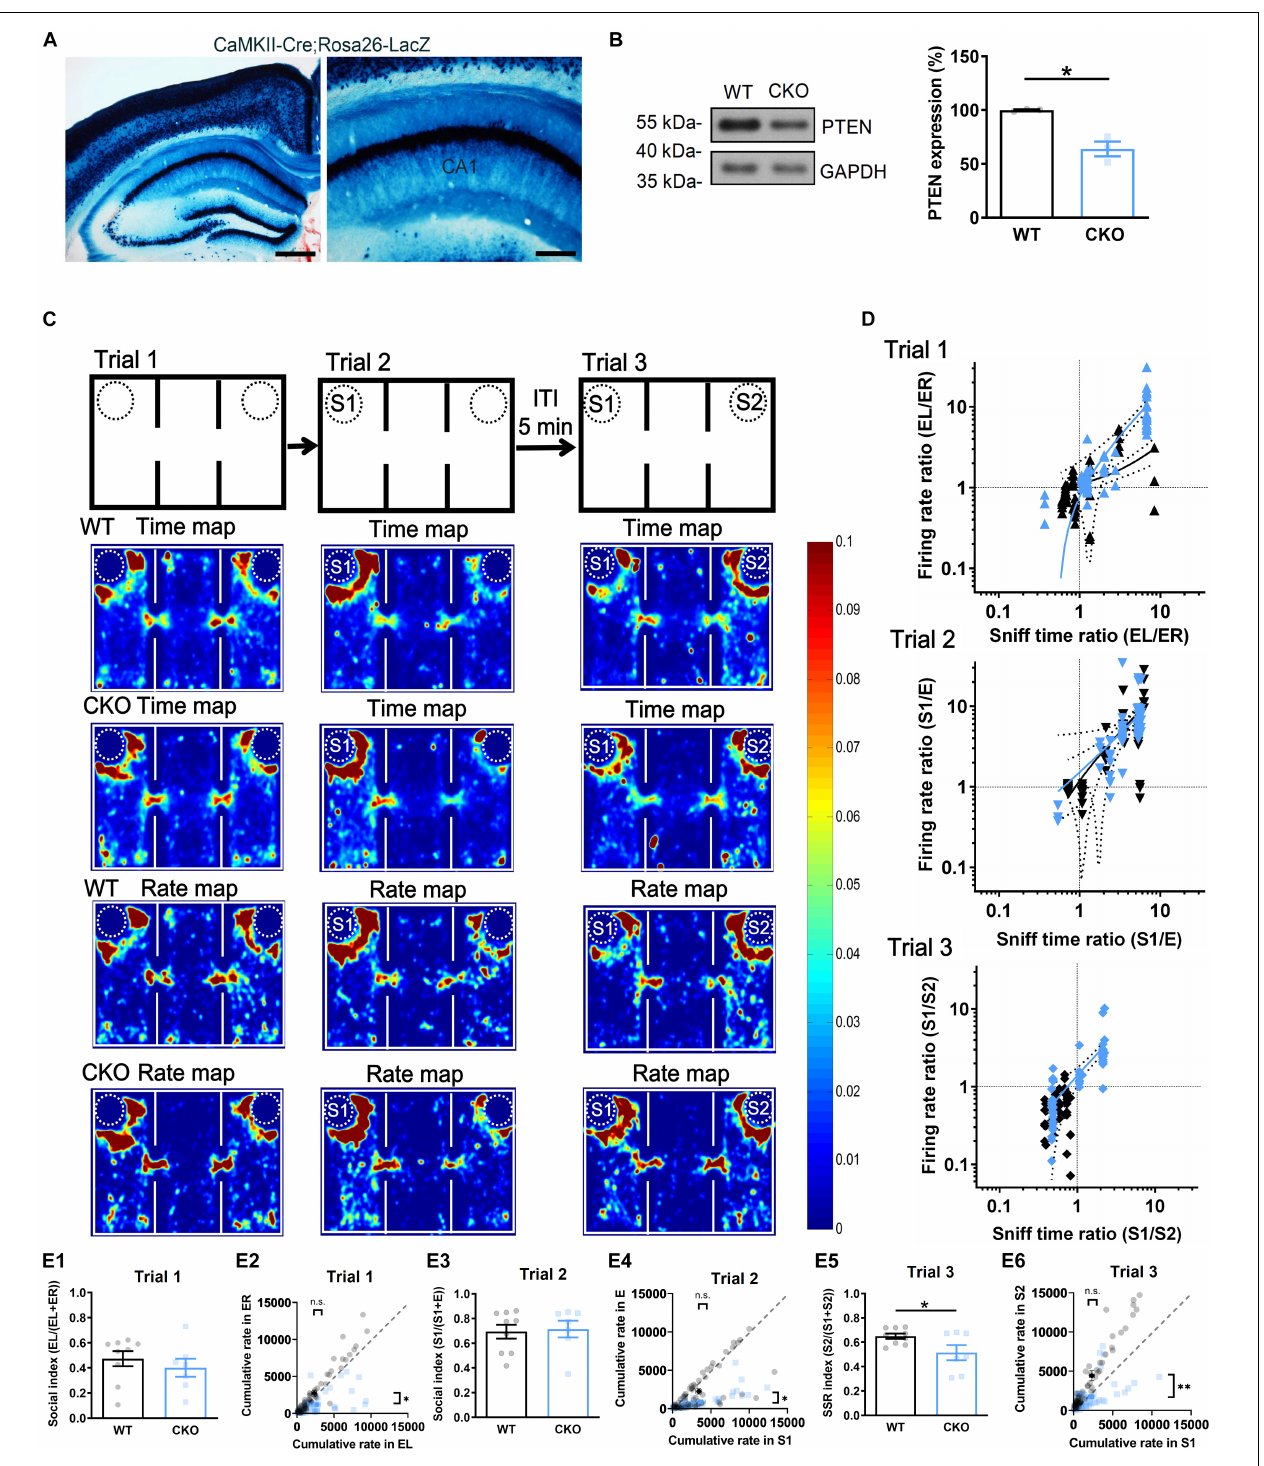
FIGURE 5 | Altered CA1 neuronal firing pattern during social recognition in conditional forebrain PTEN knockout (CKO) mice. (A) X-Gal staining of Cre activity in CaMKII-Cre;Rosa26-LacZ mouse. Calibration bars: Left, 500 µ m; Right, 200 µ m. (B) Western blot of the dorsal CA1 samples from PTEN CKO mice showed down-regulation of PTEN expression relative to WT mice ( n = 3/group; * P < 0.05). (C) Wild type (WT) and PTEN CKO mice were examined in three-chambers and three-trials social interaction test during which activity of CA1 neurons were recorded by using a multiple single-unit recording system and behavioral tracks of the mice were recorded by using a video system. Time map showing where subject mice spend their time; Rate map displaying where CA1 neuron is firing at a rate. Warmer colors represent more time or higher firing rate during 10-min per trial. Accumulated data (60 neurons from 9 WT; 59 neurons from 7 CKO) suggested